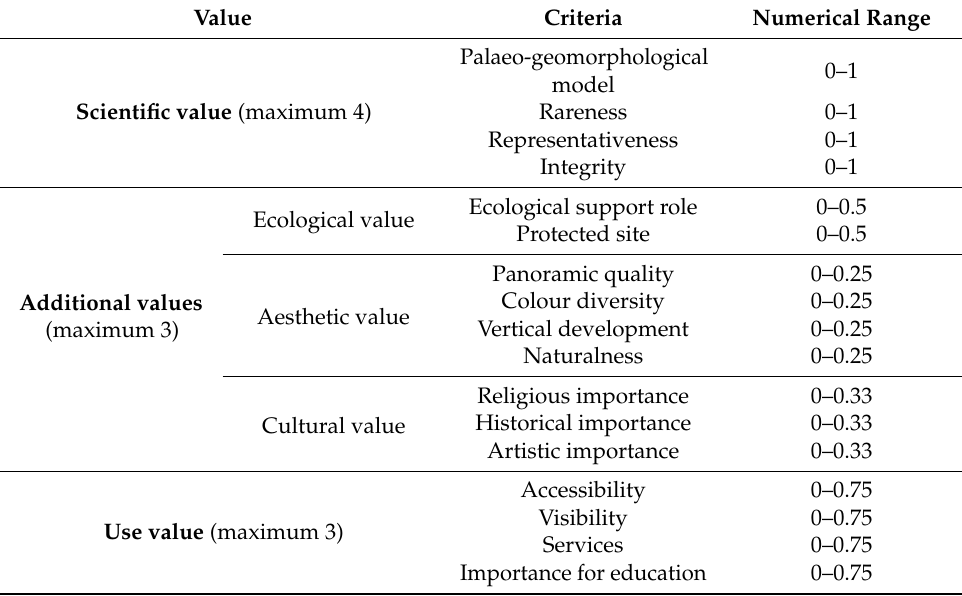
Table 1. Values, corresponding criteria and numerical range of criteria used for the quantitative assessment of